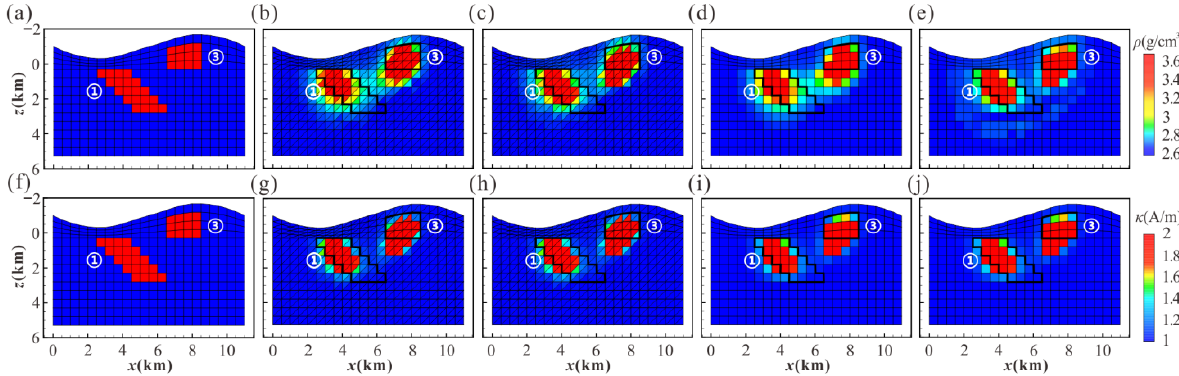
Figure 13. Slice of density (up) and magnetization (down) at y = 3500 m. ( a , f ) Real model; ( b , g ) separate result under tetrahedral grid; ( c , h ) joint result under tetrahedral grid; ( d , i ) separate result under combined hexahedral grid; ( e , j ) joint result under combined hexahedral grid.